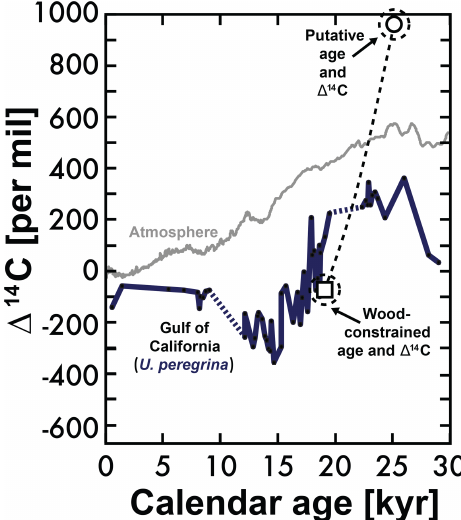
Figure 6. Comparing Gulf of California U. peregrina (cid:49) 14 C with anomalous values based on the Bayesian calendar age (circle) based on sediment depth and the wood-constrained calendar age (square). If this anomaly was not the result of human error (mislabeling of the sample depth), then this may suggest the influence of